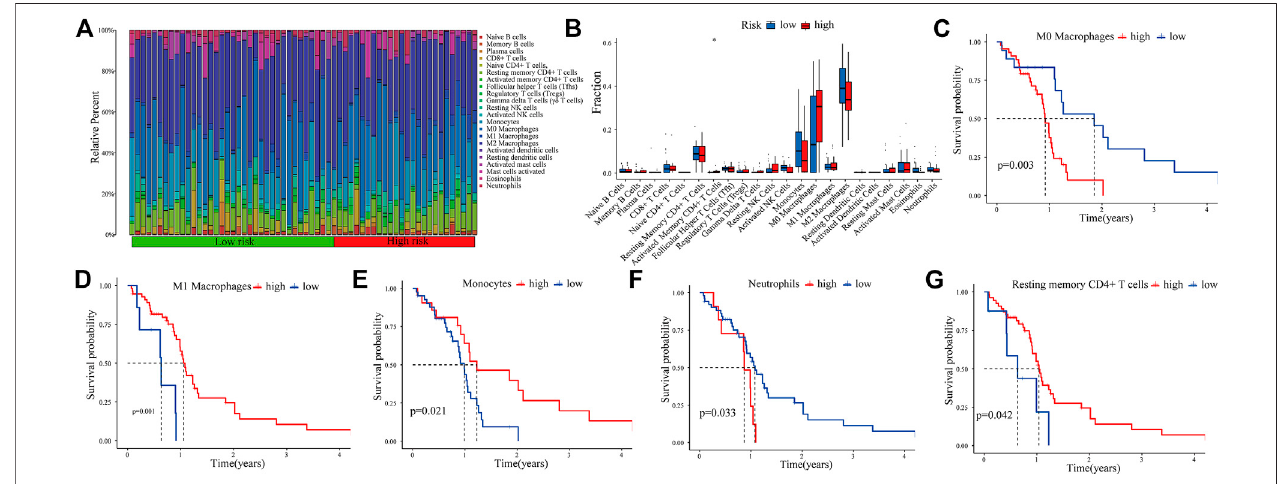
FIGURE 7 | Immune in fi ltration in GBM samples as assessed in CGGA data. The proportions of tumor-in fi ltrating immune cells (TIICs) in 22 GBM patients from the CGGA database (A) . Correlation analysis between CDCP1 expression and various types of in fi ltrating immune cells (B) . Survival analysis of the TIIC subsets (C – G)